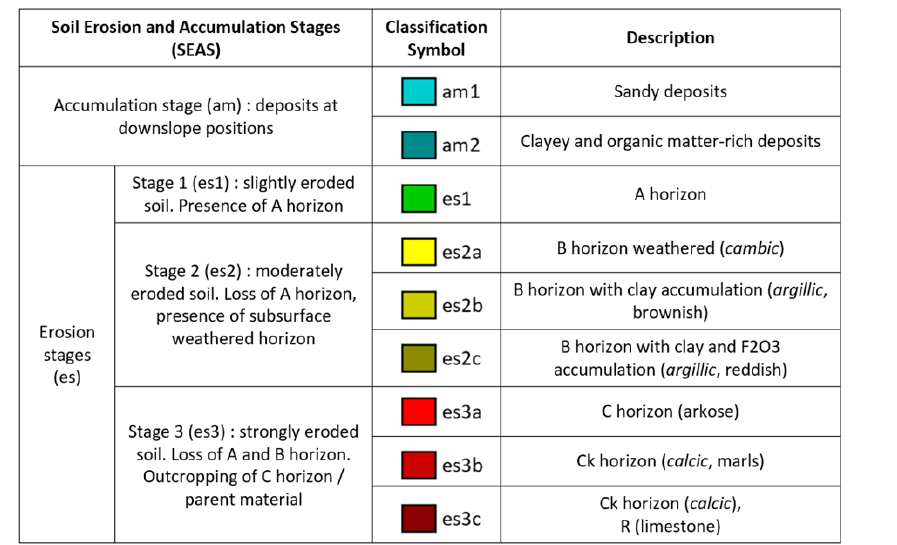
Figure 3. Description of SEAS symbology based on Schmid et al. (2016) [22].